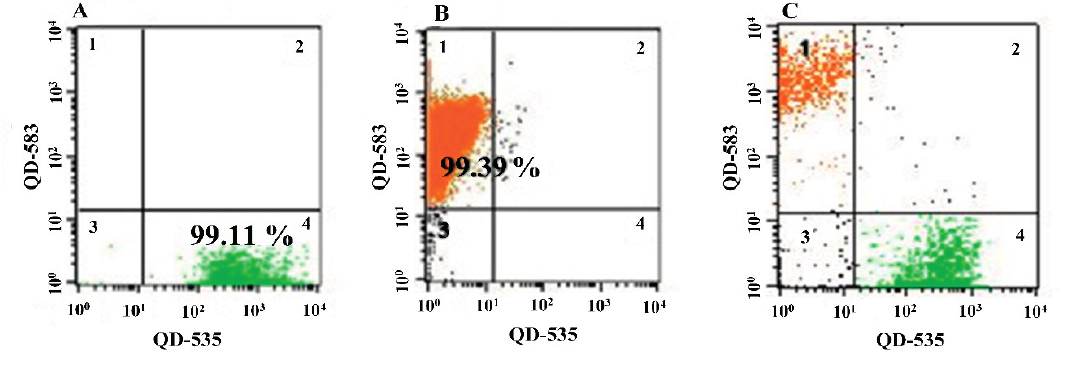
Figure 8. The flow cytometric analysis of either individual ( A ) Vibrio parahaemolyticus , ( B ) S. typhimurium ; or ( C ) a mixture of both bacteria with Apt-QDs. The percentage of bacteria detected is also indicated in the figures. The image was adopted from